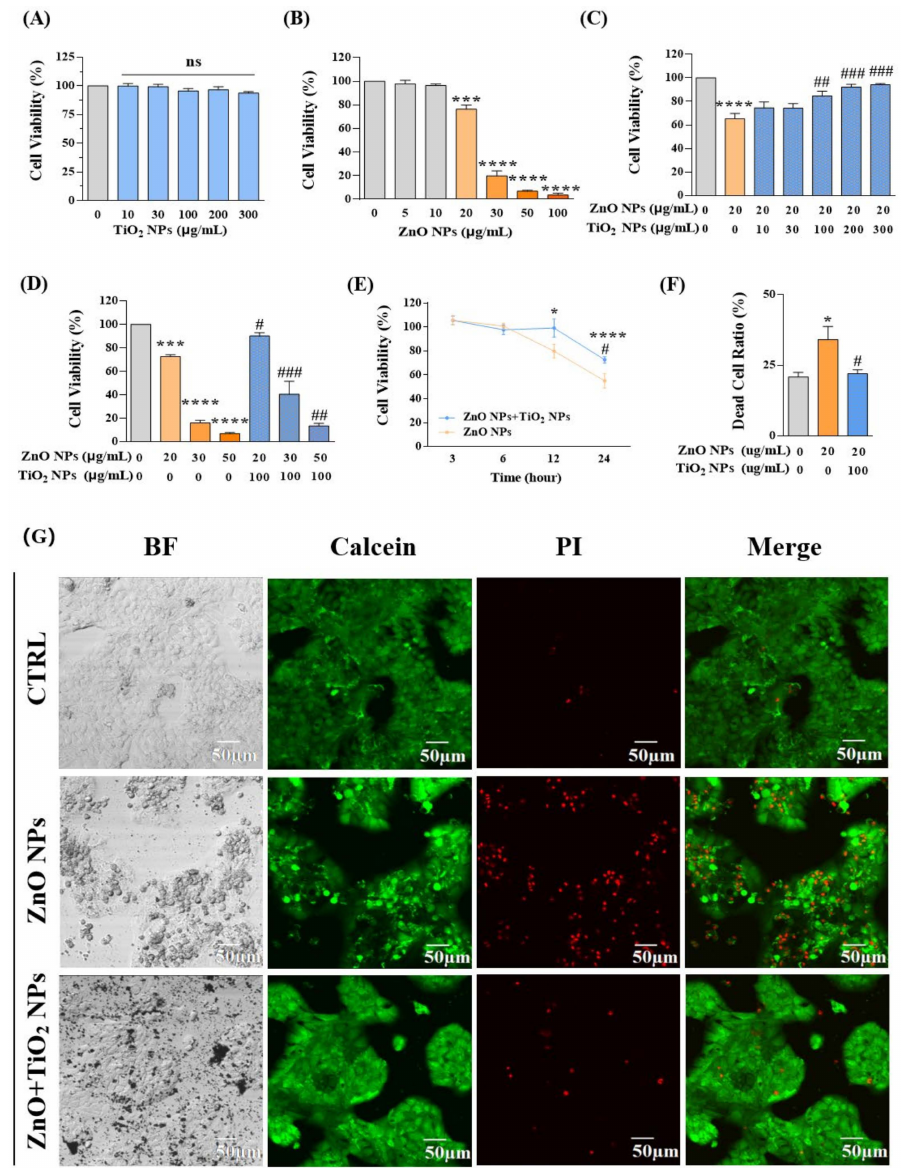
Figure 2. Co-exposure with TiO 2 NPs reduced the cytotoxicity induced by ZnO NPs alone. ( A , B ) Cell viability was measured at different doses of ( A ) TiO 2 NPs (0, 10, 30, 100, 200, and 300 µ g/mL) and ( B ) ZnO NPs (0, 5, 10, 20, 30, 50, and 100 µ g/mL). ( C , D ) Effects on cell viability caused by co-exposure of ZnO NPs and TiO 2 NPs. ( E ) Time-dependent toxicity curves were obtained in both ZnO NP- treated and NP mixture-treated groups for 3, 6, 12, and 24 h. ( F , G ) Confocal microscope images ( G ) and statistical analysis ( F ) for calcein/PI (dead/living cells) dual staining. * p < 0.05, *** p < 0.001, **** p < 0.0001 compared to the control group. # p < 0.05, ## p < 0.01, ### p < 0.001 compared to ZnO NP-treated